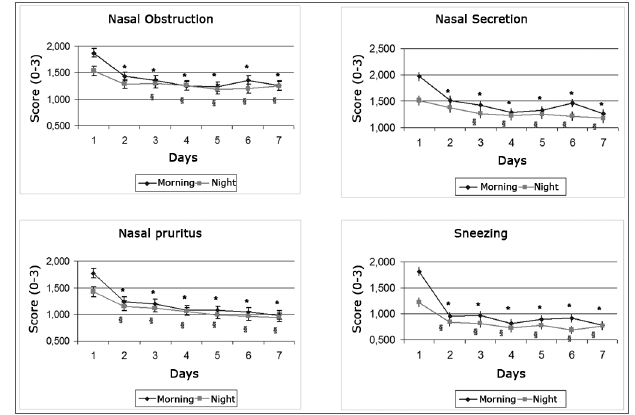
Graph 2. Daily evolution of nasal symptoms within the first seven days of treatment.